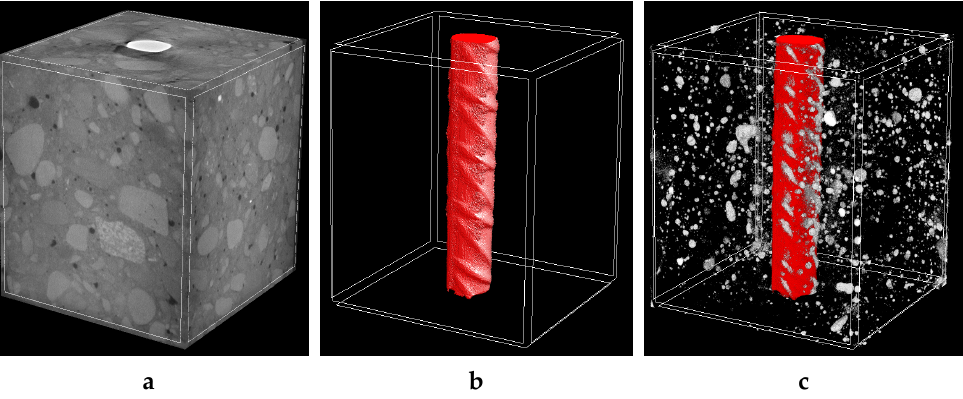
Figure 4. The 3D visualization of reinforced concrete sample no. 2: ( a ) entire sample, ( b ) steel reinforcement bar and ( c ) steel reinforcement bar with air void distribution.